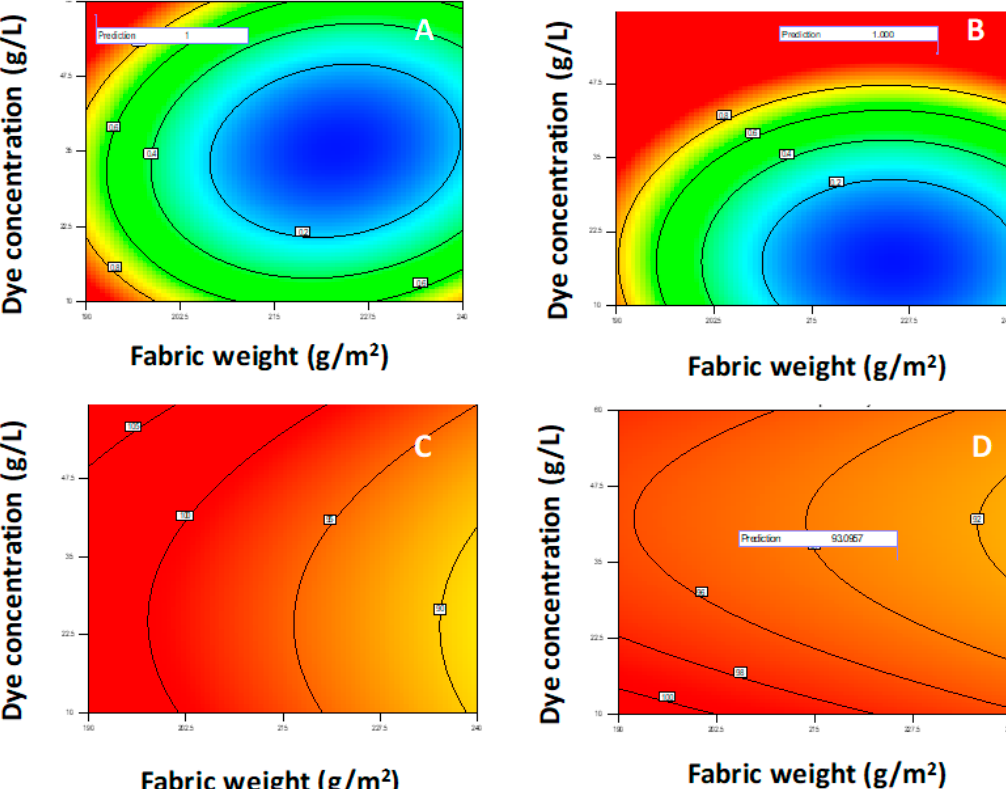
Figure 8. ( A – D ): Surface contour plots for desirability, water vapor permeability, and resistance to water wetting at optimal values of initial fabric weight (g / m 2 ) and dye concentration (g / L) for di ff erent values of other parameters: ( A ) C = 51.386, D = 159.109, E = 1.504, F = Sevophob HFK-F; ( B ) C = 61.437, D = 156.768, E = 1.228, F = Tubiquard SCS-F; ( C ) C = 51.756, D = 150.309, E =